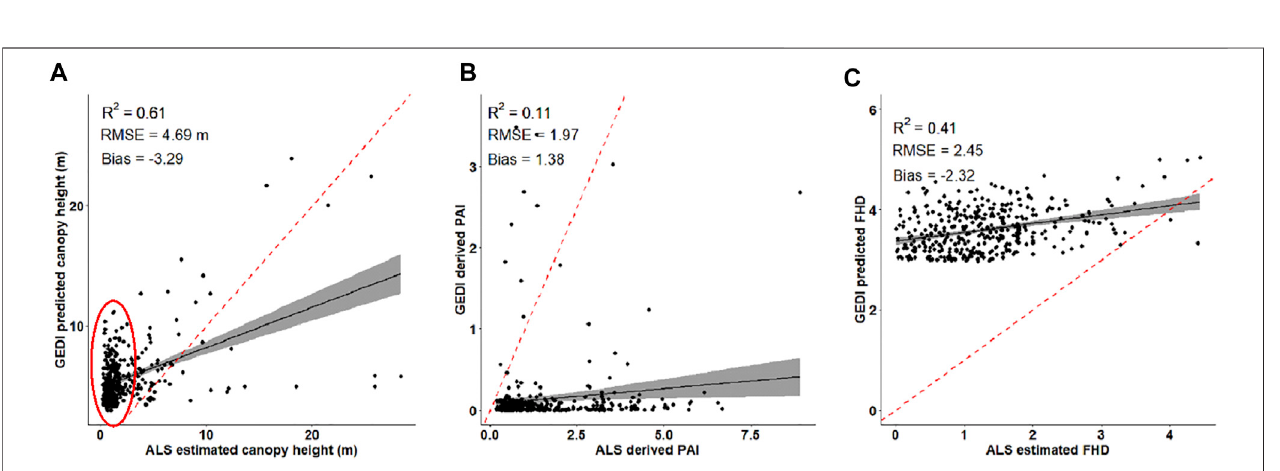
Frontiers in Remote Sensing |